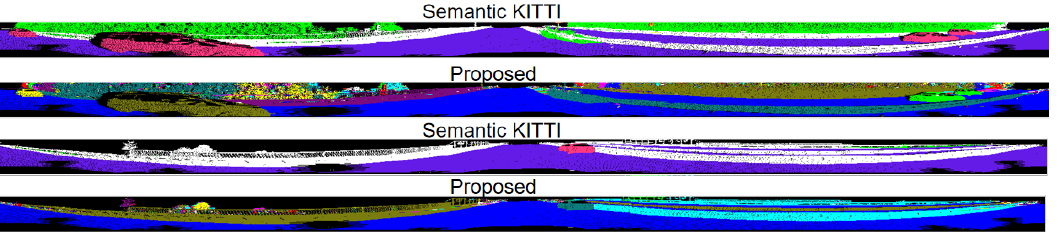
Figure 8. The upper image is the result of Semantic KITTI annotation, and the lower image is the result of using our clustering algorithm. Each pixel represents a point cloud, and different colors represent different categories. The traffic objects on the road are well